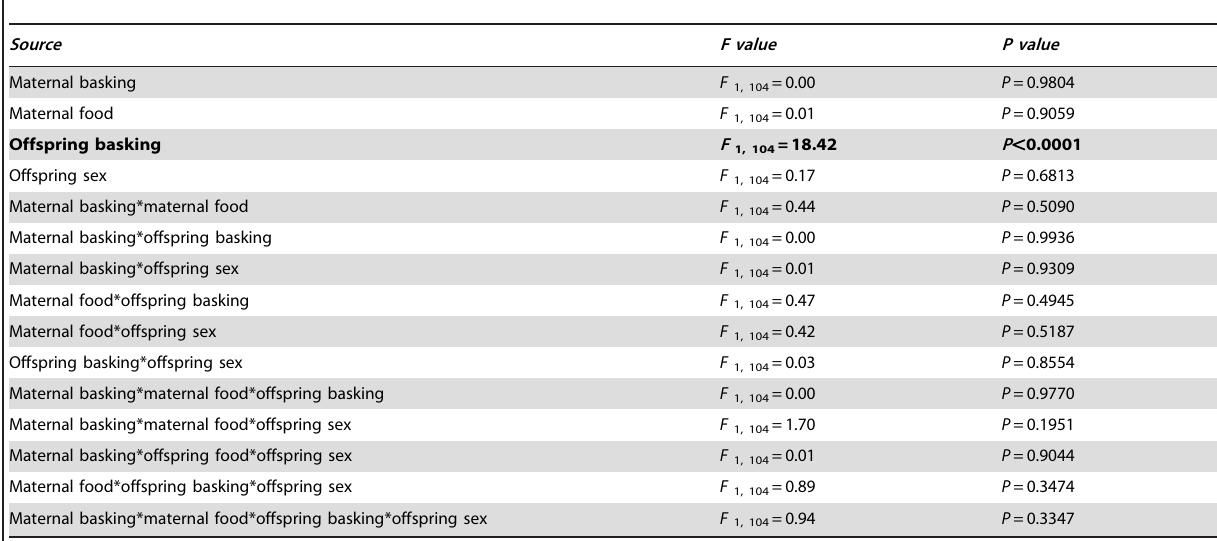
Summary of the results of statistical analyses of the effects of maternal basking and food availability (combinations of extended and restricted basking opportunities and food supply) during gestation, offspring basking availability (extended and restricted basking opportunities), offspring sex and their interactions on offspring growth rates in Pseudemoia entrecasteauxii . The significant result is indicated in bold.